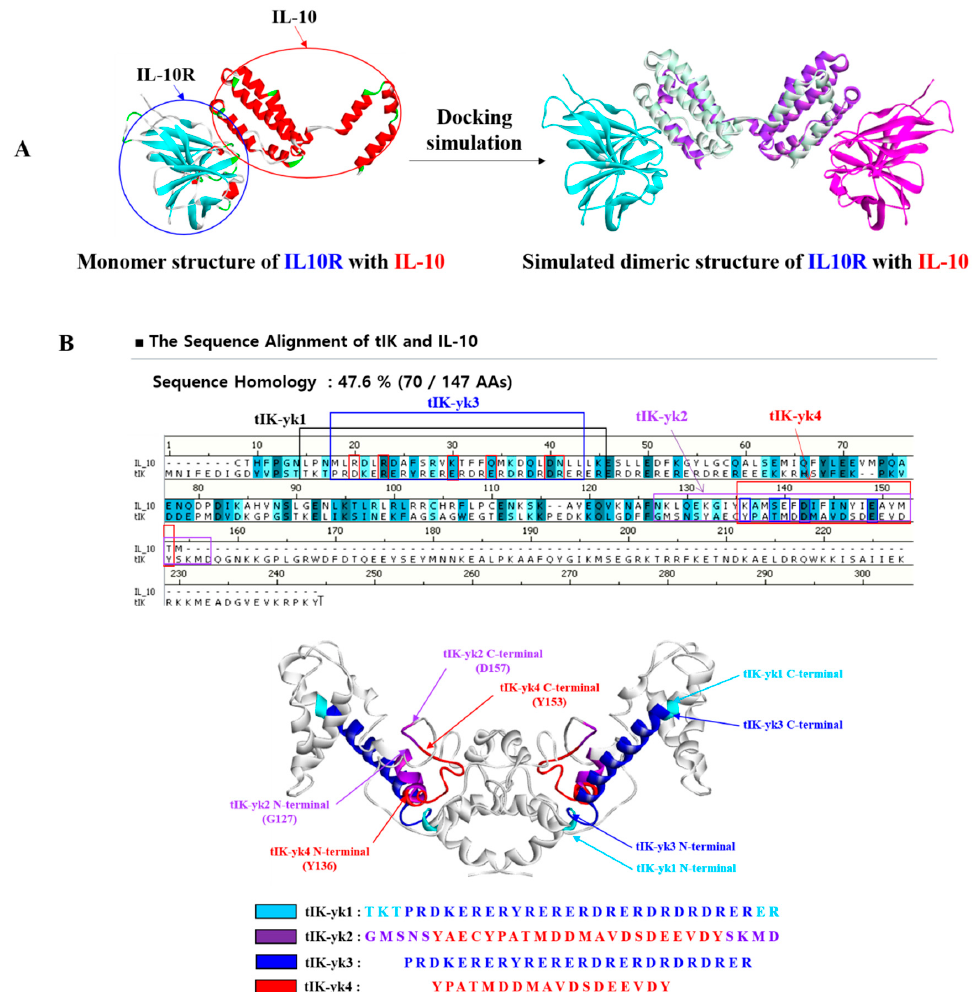
Figure 2. ( A ) Through docking simulation, it was visually confirmed that the IL-10R and IL-10, which are phosphorylated by the tIK protein, bind in homodimeric form. The left part of the Figure shows the monomeric structure of IL-10R and IL-10. ( B ) Sequence alignment of tIK and IL-10. Considering that tIK protein phosphorylates IL-10R, homology modeling was performed with the full-length sequence of the IL-10 and tIK proteins. The degree of homology was about 48%, indicating very high sequence similarity between the two peptides. The higher the homology for each amino acid portion, the darker the color of the corresponding area. IL-10 is bound to the IL-10R, indicated by a rectangular box. Four tIK epitope sequences were proposed based on an active site that is highly homologous to